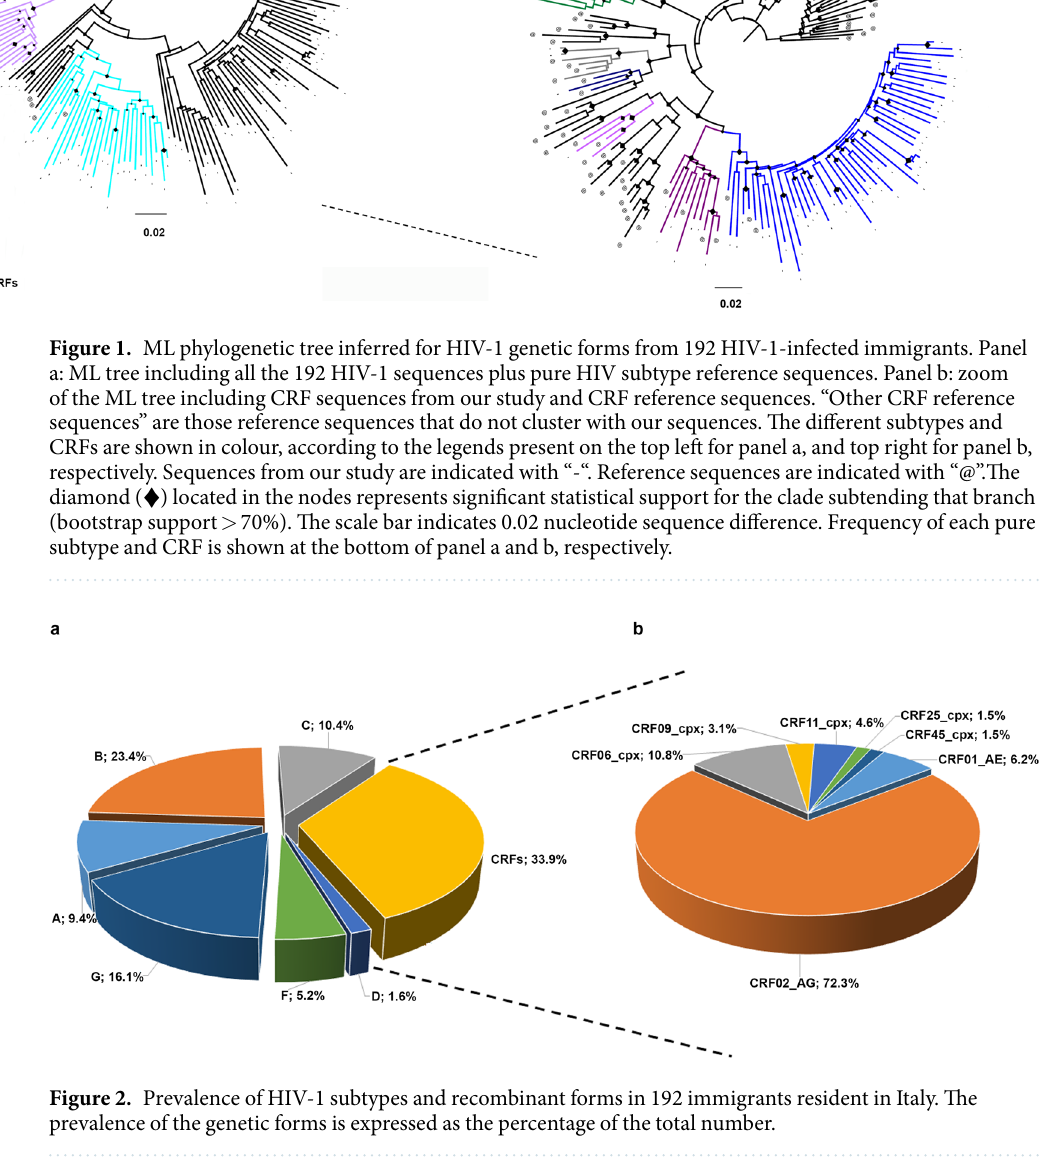
heterosexual intercourses in natives (41.9% and 32.4%, respectively) and unprotected heterosexual intercourses in immigrants (58.8%). data (Figs. 4, 5 and 6). Figure 4 reports the ML tree of subtype B sequences. There is only one statistically supported cluster (bootstrap value > 0.7), including 4 sequences from male patients, 2 from drug abuser immigrants, one from an immigrant who reported both drug use and unprotected heterosexual contacts, and a fourth one from an autochthonous